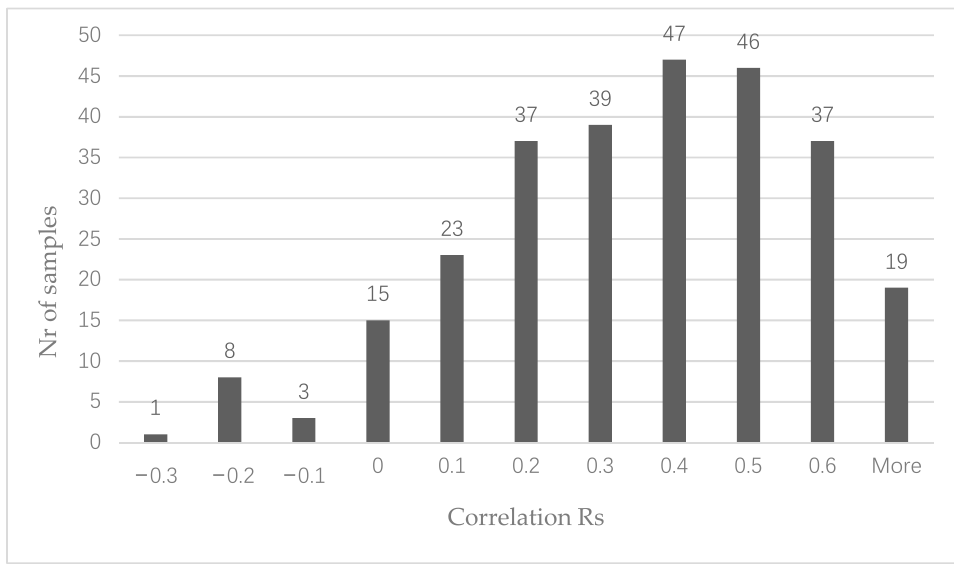
Figure 2. Histogram showing the distribution of the observed correlations between the number of circRNA and mRNA reads per gene.